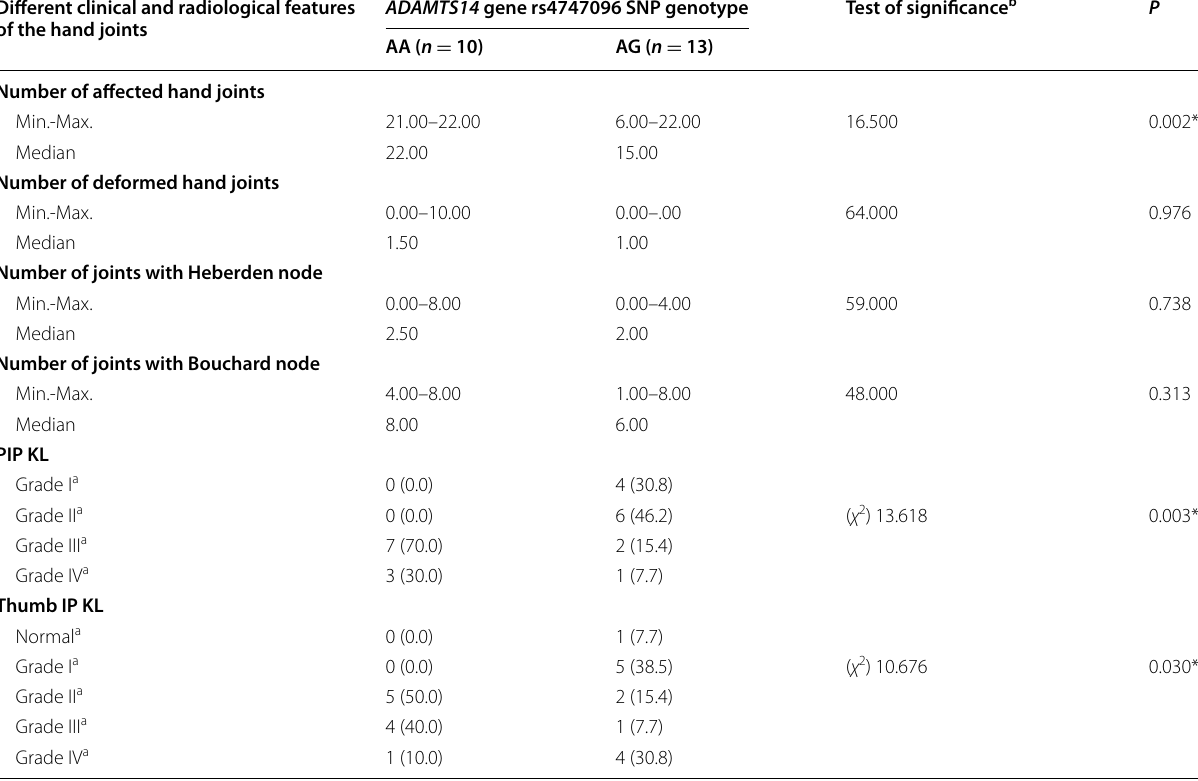
Table 3 Association between ADAMTS14 gene rs4747096 single nucleotide polymorphism genotype and different clinical and radiological features of the hand joints in the generalized osteoarthritis patient